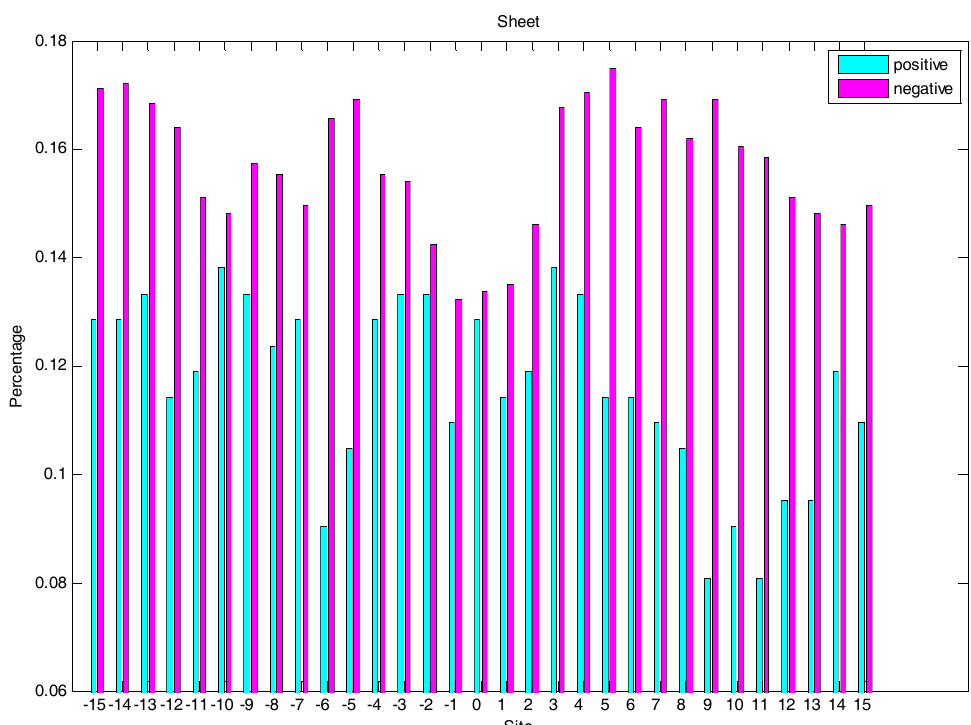
Figure 6. The distribution of the sheet structure of residues around glycation and non-glycation sites.